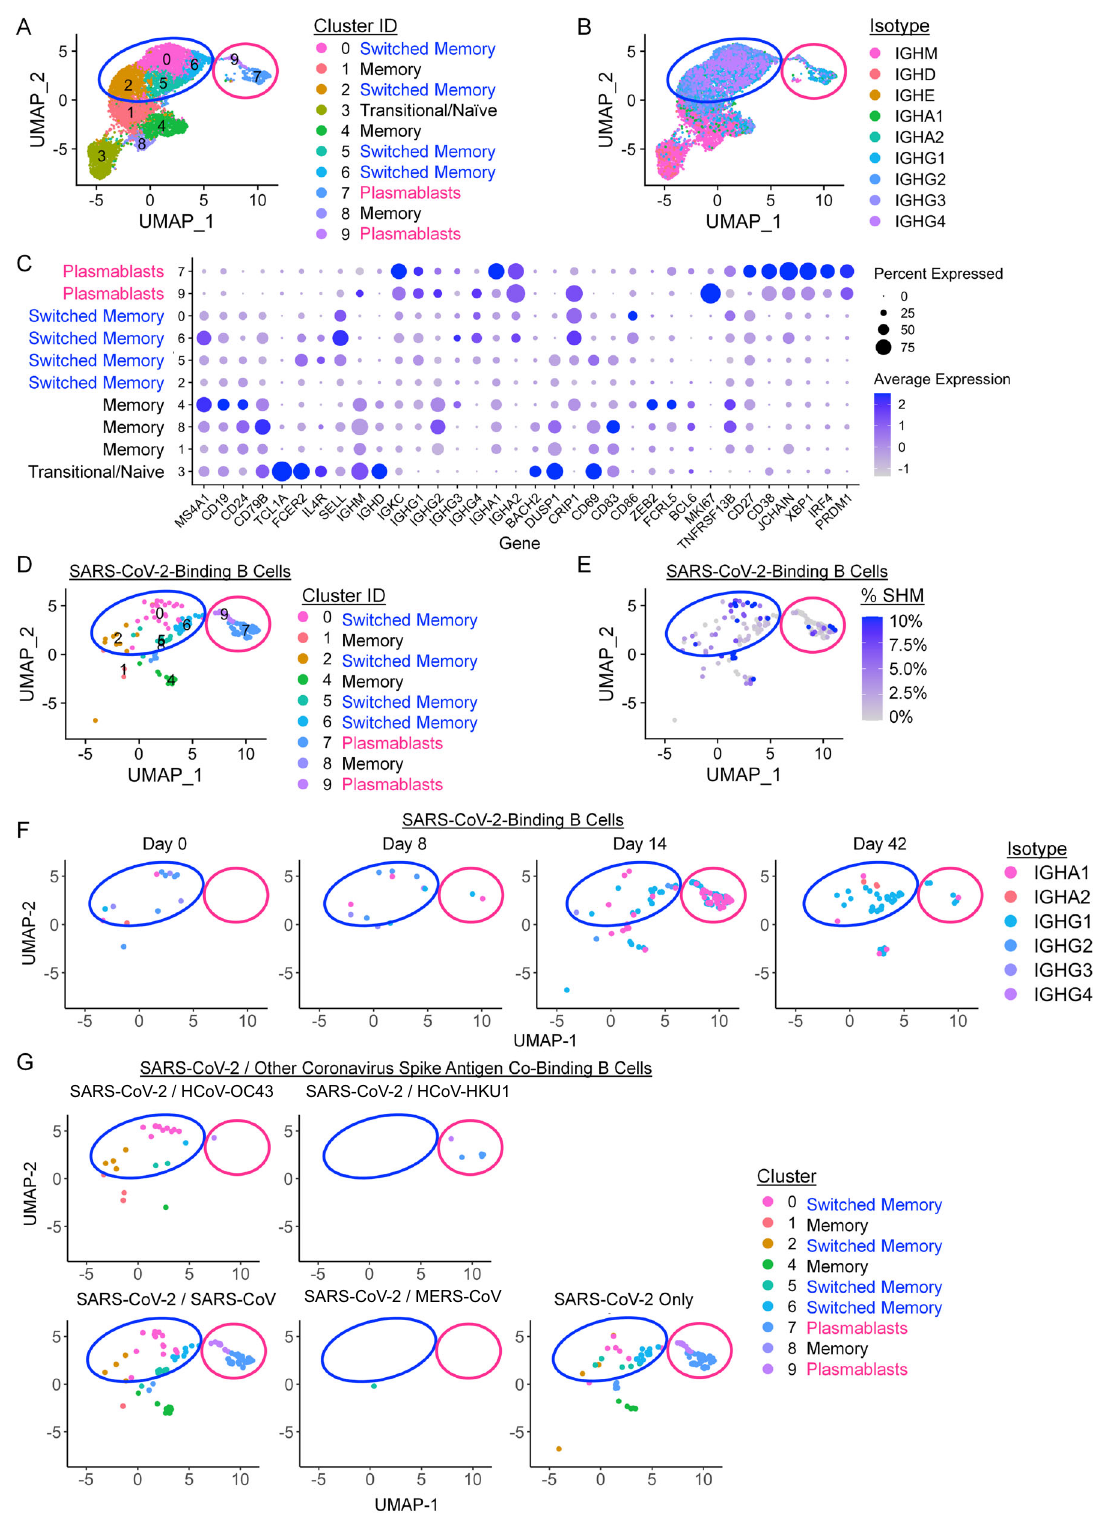
Fig. 7 BNT162b2 vaccination drives IgG and IgA-switched SARS-CoV-2-binding memory B-cell and plasmablast expansion. B cells that bound a panel of LIBRA-seq antigens were puri fi ed from peripheral blood samples and single-cell RNA-seq/BCR-seq/LIBRA-seq data were integrated. Cells were scored positive for binding a given antigen for LIBRA-seq scores ≥ 1. A UMAP identi fi ed clusters of B cells based on transcriptional similarity. Antibody-secreting cells (pink circle encompassing clusters 7 and 9) and isotype-switched memory B cells (blue circle encompassing clusters 0, 2, 5, and 6) are highlighted across all UMAP plots. B BCR isotypes are shown among sorted B cells. C Selected gene expression pro fi les within each cluster are shown. D – F SARS-CoV-2-binding B cells were identi fi ed using LIBRA-seq and non-class-switched B cells were fi ltered out for detailed analysis. D UMAP identi fi ed clusters of SARS-CoV-2-binding B cells based on transcriptional similarity. E IgH somatic hypermutation frequency of SARS-CoV-2-binding B cells is indicated. F SARS-CoV-2-binding B-cell isotypes are shown for each time point. G SARS-CoV-2-binding B cells are shown, each panel indicates cells that also bound the indicated coronavirus S